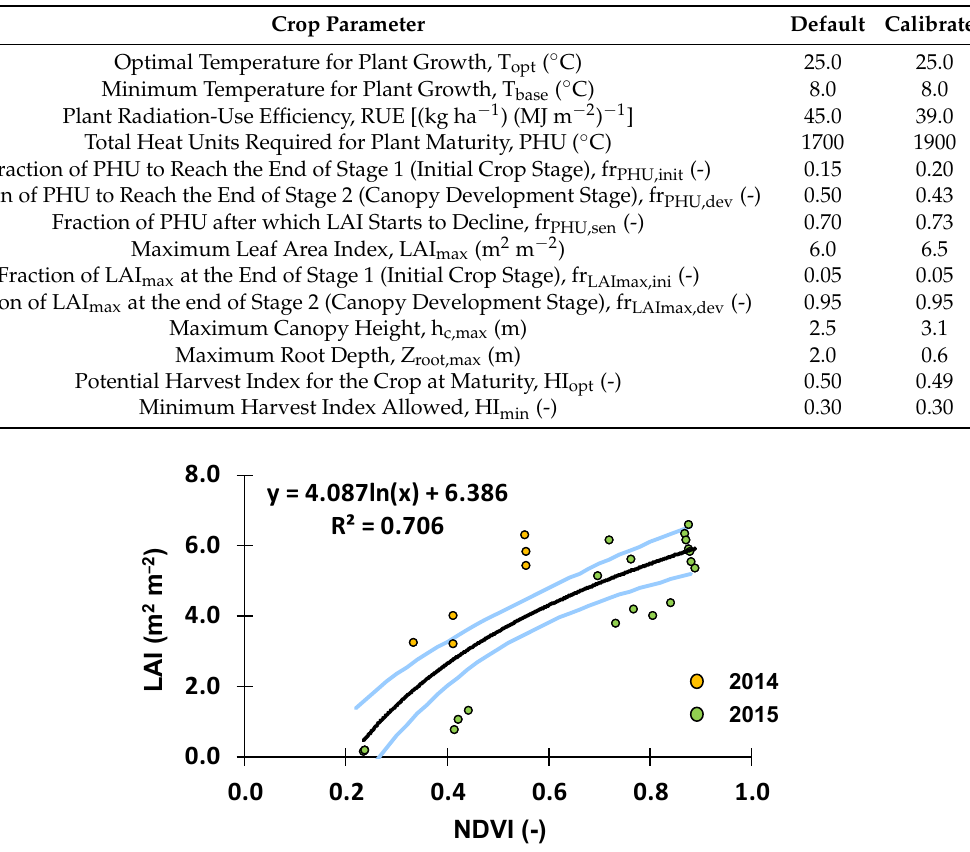
Table 4. Parameters of the crop growth model.